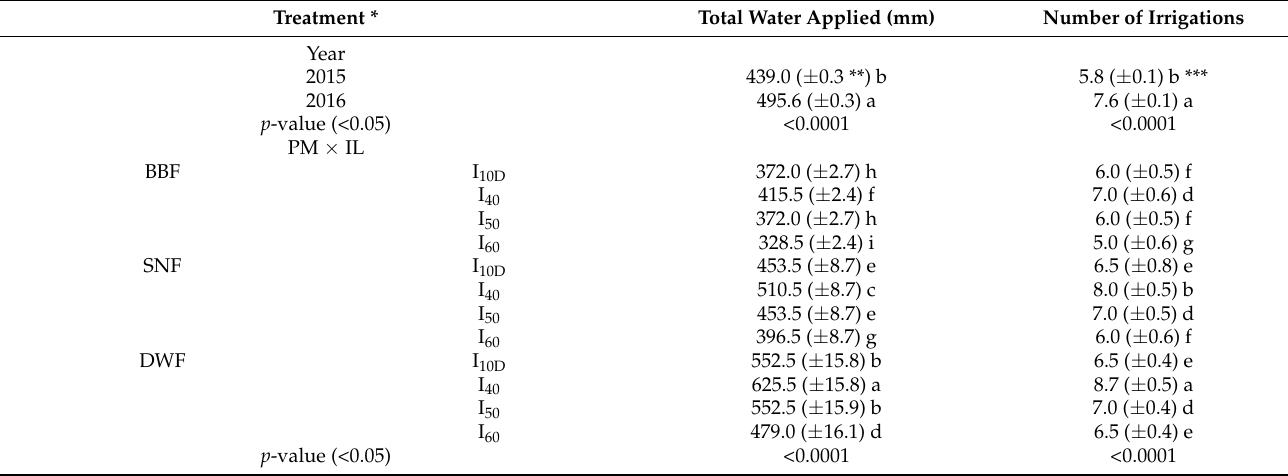
Figure 2. Grain ( A , B ) and stalk ( C , D ) yields of maize in response to planting methods and irrigation levels. Means followed by the same letter (s) within a column are not significantly different. Table 9. Effect of planting methods and irrigation levels on total water application and number of irrigations in